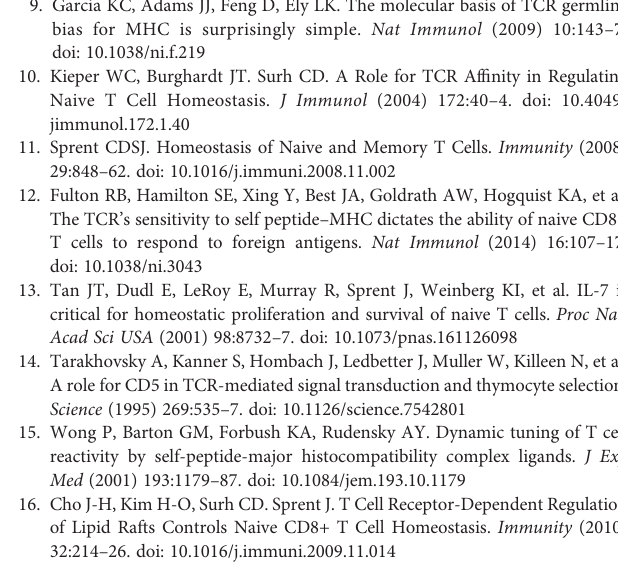
Supplementary Figure 1 | Proportion of various TCR a and b chains on CD4 + T cellsin Themis – / – (red) and Themis +/+ (blue)mice.Data are representative from three independent experiments with 4-5 biological replicates per genotype per experiment. *p<0.05, **p<0.01, ***p<0.001, ****p<0.0001 as determined by two- sided Student ’ s t-test. All error bars represent SDs. Supplementary Figure 2 | (A) Correlation between CD5 and CD6 cell surface expression on peripheral naïve CD4 + (CD25 – , CD44 low ) and CD8 + (CD44 low ) T cells. CD5 and CD6 MFI on 10% cells with highest (CD5 high ) and lowest (CD5 low ) cell surface expression. Data from 8 mice, pooled from 2 independent experiments. (B) Sorted naïve (CD44 low ) OT-I CD8 + T cells were transferred into b 2 m WT or KO recipients, followed by CD5 and CD6 surface staining of lymphocytes 24h later. Data from 1 experiments, using 3 ( b 2 m KO) and 6 (WT) recipient mice. (C) Gating strategy for CD44 lo cells from Themis – / – and Themis +/+ mice. Data are representative from three independent experiments with 4-5 biological replicates per genotype per experiment. *p < 0.05, **p < 0.01, ***p < 0.001, ****p < 0.0001 as determined by two-sided Student ’ s t-test. All error bars represent SDs. Supplementary Figure 3 | (A) V a and J a segment usage in the thymic SP CD8 TCR a repertoire. (B) Distribution of the amino acids within CDR3 regions. (C) Hydrophobicity (upper panel) and charge (lower panel) of the CDR3 regions from V a 3.2 + (TRAV9N-3) and non-V a 3.2 receptors. 100 most dominant clones from entire repertoires were analyzed. Supplementary Figure 4 | Proliferation of V a 3.2 + and non-V a 3.2 + naïve CD8 + T cells from Themis – / – and Themis +/+ mice in (A) lymph nodes and (B) spleen of Rag1 – / – hosts. Histogram summary of the proliferation responses in (C) lymph nodesand (D) spleen of Rag1 – / – hosts.ProportionofV a 3.2 + andnon-V a 3.2 + CD8 + T cells from Themis – / – and Themis +/+ mice that had more than two divisions in (E) lymph nodes and (F) spleen of Rag1 – / – hosts. Data representative from two independent experiments with 4-5 biological replicates per genotype per experiment. *p < 0.05, **p < 0.01, ***p < 0.001, ****p < 0.0001 as determined by two-sided Student ’ s t-test. All error bars represent SDs. Supplementary Figure 5 | (A) Representative histograms of CD8 + Tetramer + cells in uninfected and infected Themis – / – and Themis +/+ mice onday 4 and day 7 of LM-OVA infection. (B) Gating strategy for bystander cells. (C) Representative FACS plots of bystander cells in uninfected and infected Themis – / – and Themis +/+ mice on day 4 of LM-OVA infection. (D) Proportions of V a 3.2 + and non-V a 3.2 + CD8 + T cells from uninfected and LM-OVA- infected Themis – / – and Themis +/+ mice which were IFN- g + upon IL-12+18 stimulation. Data are representative from three independent experiments with 3-4 biological replicates per genotype per